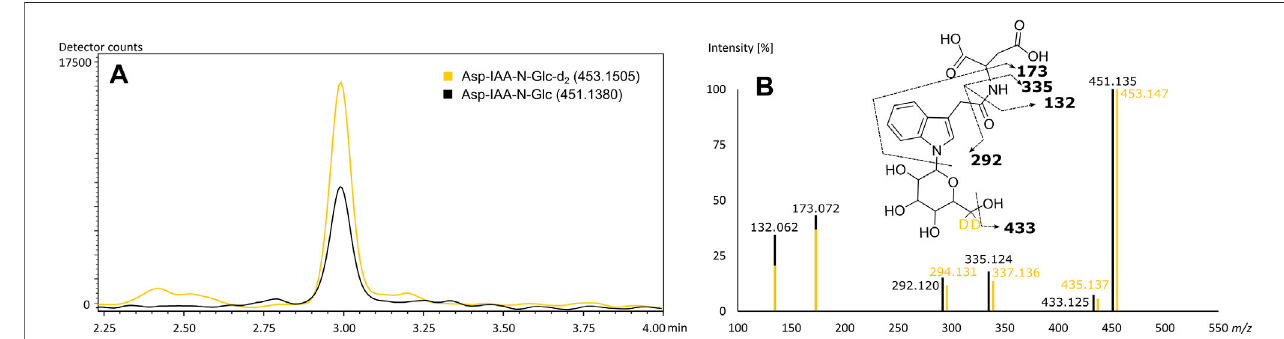
FIGURE5| Co-chromatography ofthe(6, 6-d 2 )N- β -D-glucopyranosyl-indole-3-acetic standard and its isotopologue naturallyoccurring in beer (A) withmatching MS 2 -fragmentation spectra in ESI-negative (B) . Extracted ion chromatograms of the corresponding m/z values of Asp-IAA-N-Glc-d 2 (yellow) and of